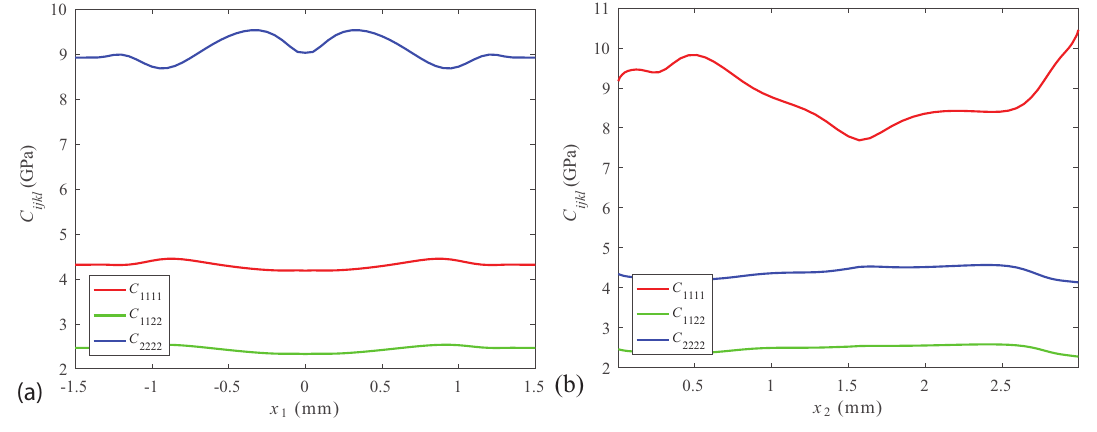
(cid:68) (cid:69) C ijkl Figure 5. Components of from using the IRD model with C I = 10 − 2 ( a ) as a function of x 1 at the nozzle exit, and ( b ) as a function of x 2 within the deposited bead.